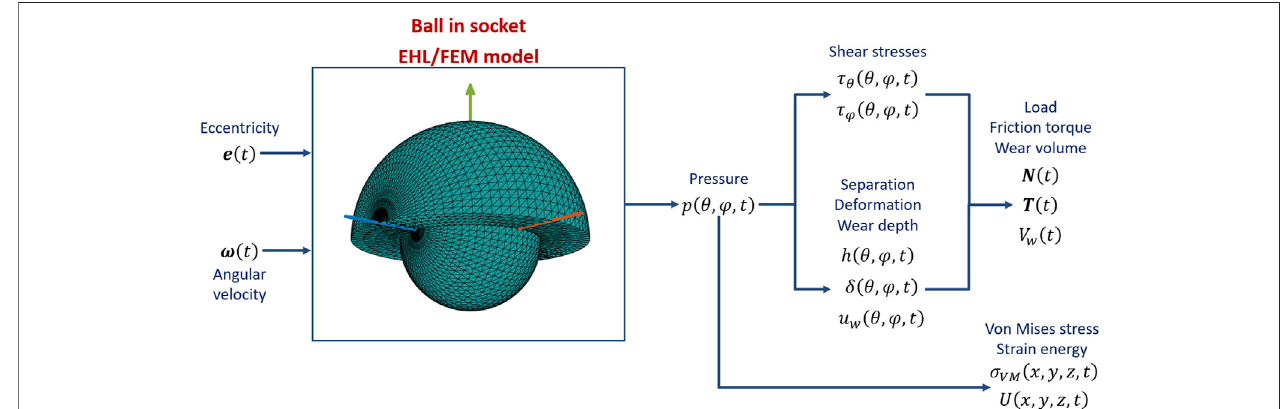
FIGURE 4 | Input/output scheme of the developed